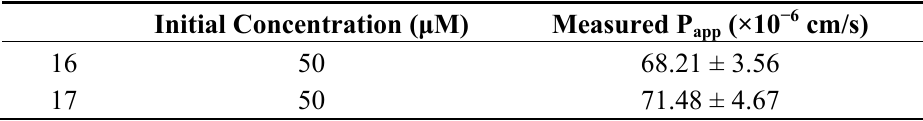
Table 2. P values of the two app